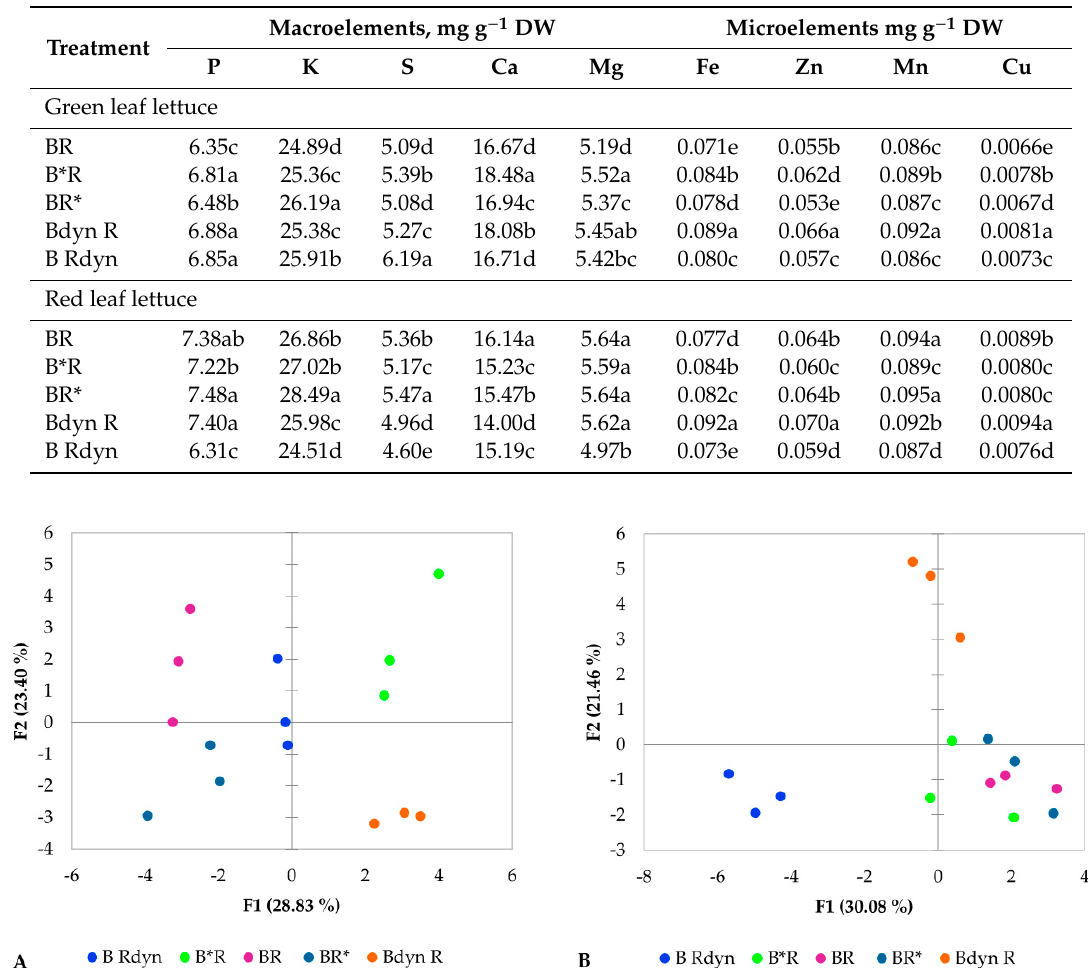
Figure 4. The PCA scatterplot, indicating distinct differences in green ( A ) and red ( B ) leaf lettuce, cultivated under dynamic lighting strategies.